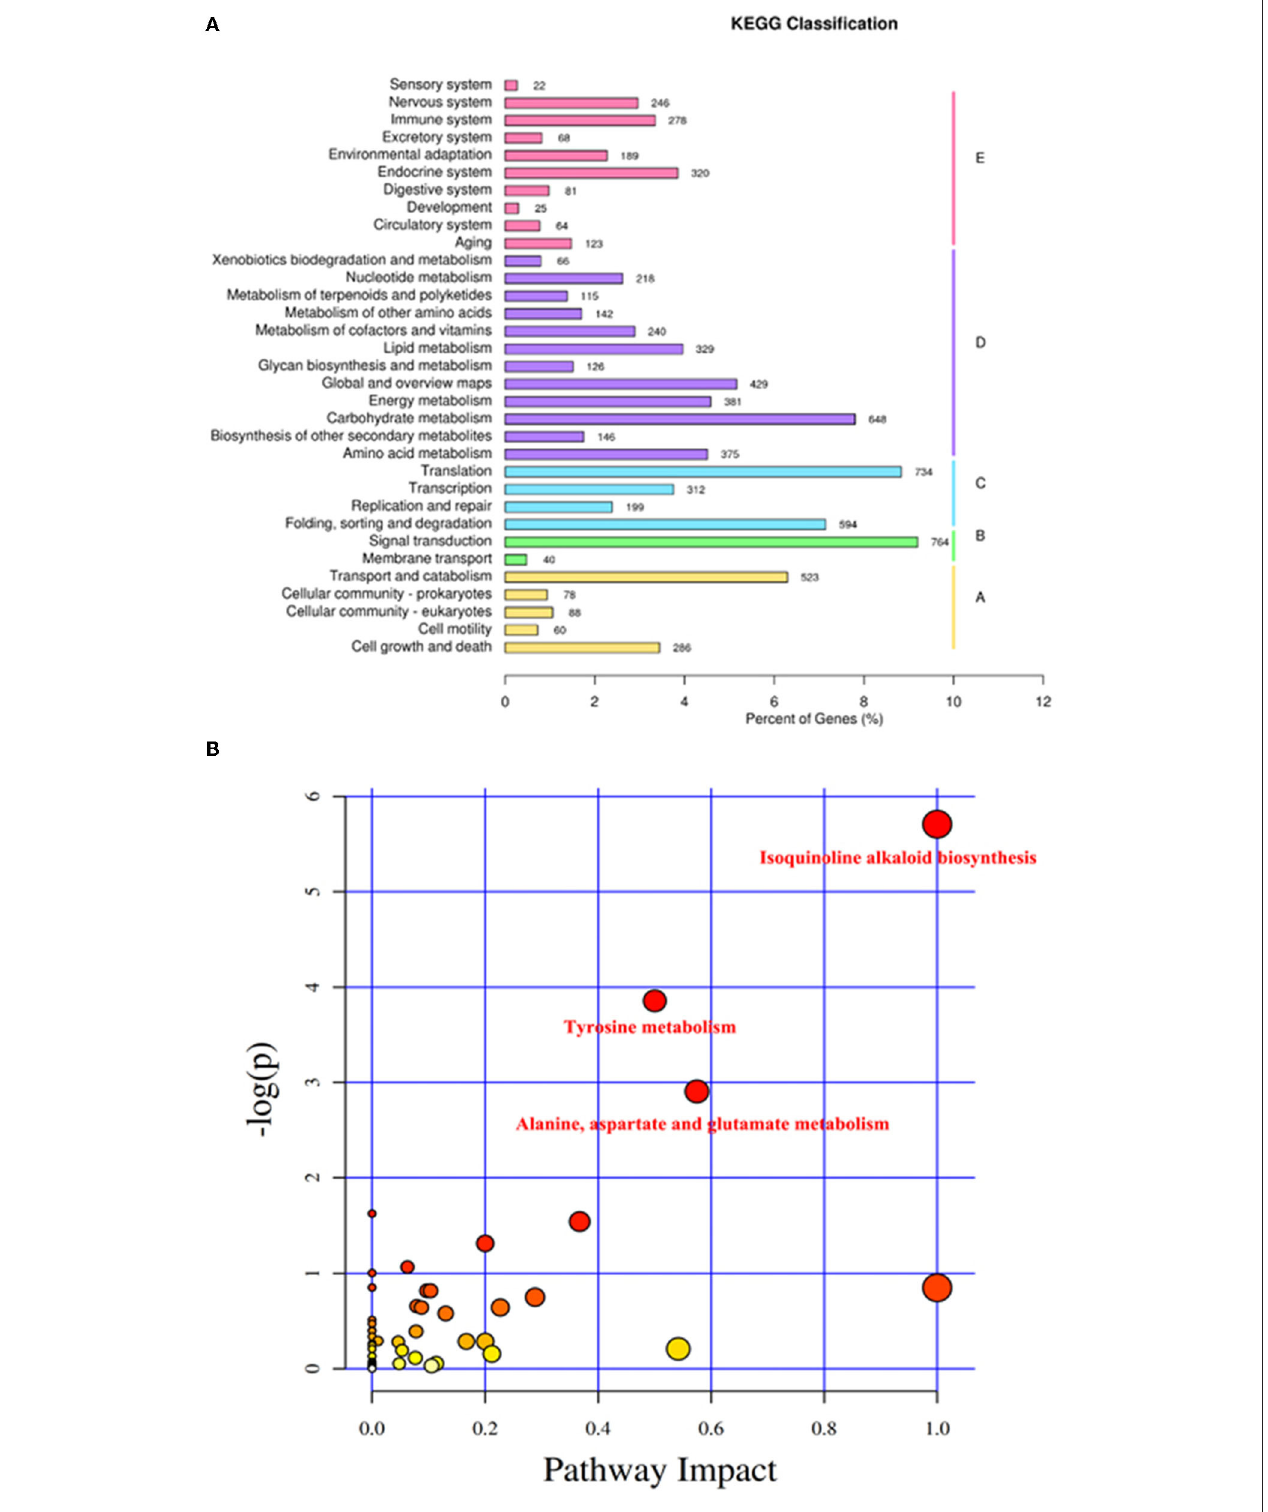
FIGURE 6 | KEGG classification and key KEGG pathway analysis of transcriptomics. (A) KEGG classification of transcriptomics. Genes were divided into five branches according to the KEGG pathways involved in I, Cellular processes; II, Environmental information processing; III, Genetic information processing; IV, Metabolism; and V, Organismal systems. The Y-ordinate represents the name of the KEGG metabolic pathway, and the X-ordinate represents the number of genes annotated to this pathway and their proportion to the total number of genes annotated. (B) Key KEGG pathway analysis of low-temperature storage of